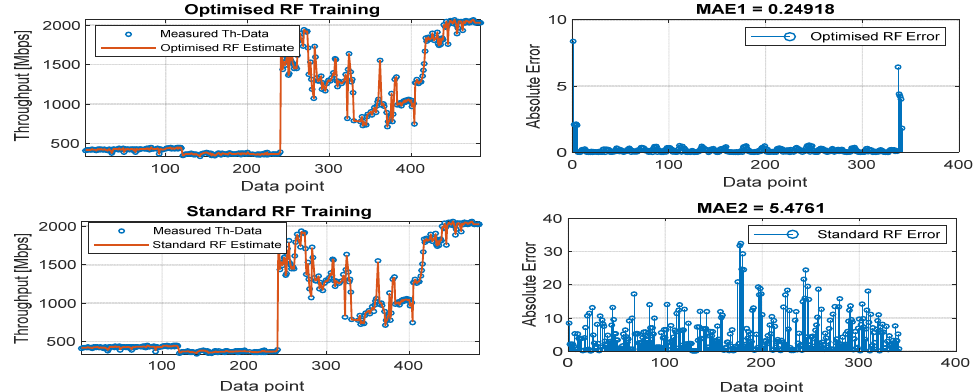
Figure 9. Predicted throughput quality performance of the proposed RF-LS-BPT model and standard RF model at 50 m distance.